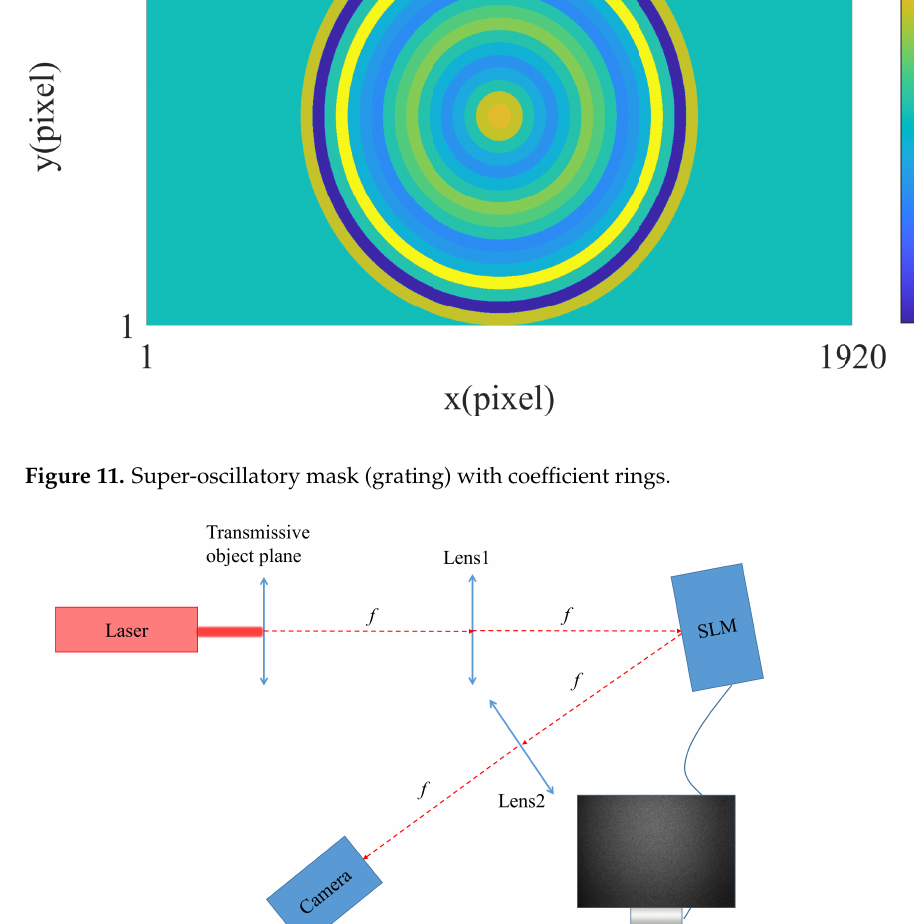
Figure 12. The optical 4F system (NA = 0.00864, f = 40 cm, λ = 632.8